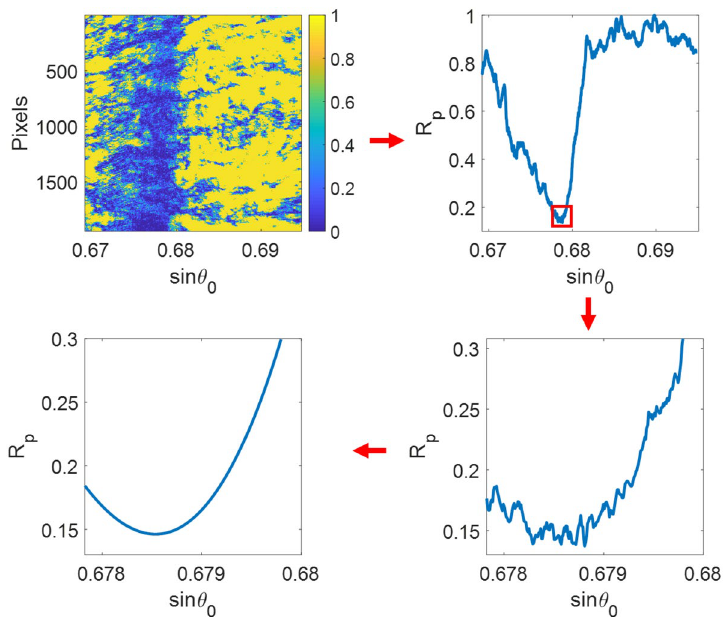
Figure 2. Steps in the cubic polynomial curve fitting-based method for determining the minimum position of SPR reflectance dip.